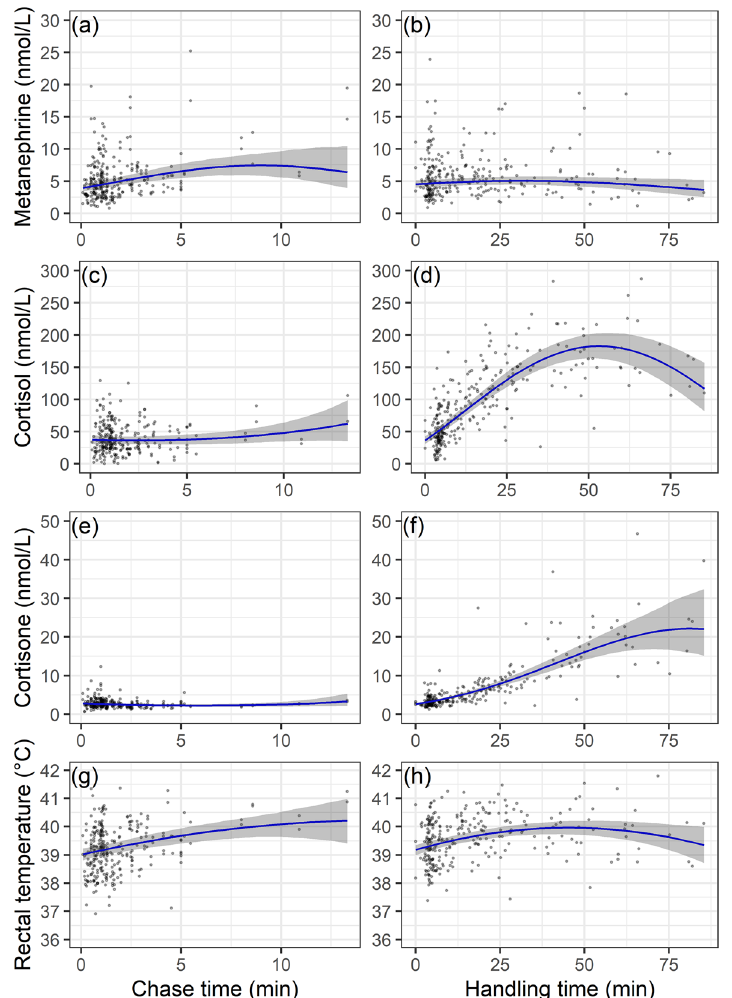
Figure 3. Values of the acute stress response shown as a function of stressor intensity (chase and handling duration) of female Svalbard reindeer. Chase is defined as the time from when the reindeer begins to run until it is caught in the net. Handling is defined as the time from the reindeer is caught until the blood sample was taken. Blue lines show the predicted response (with 95% credible intervals) for an average individual (6 years old, 4.5 catches in previous years, second catch of the current year, not sedated). For handling times, points are adjusted for sedation, individual, age, year of study and chase time. For chase time, points are adjusted for the handling time, i.e.: from the animal was caught until the sample was